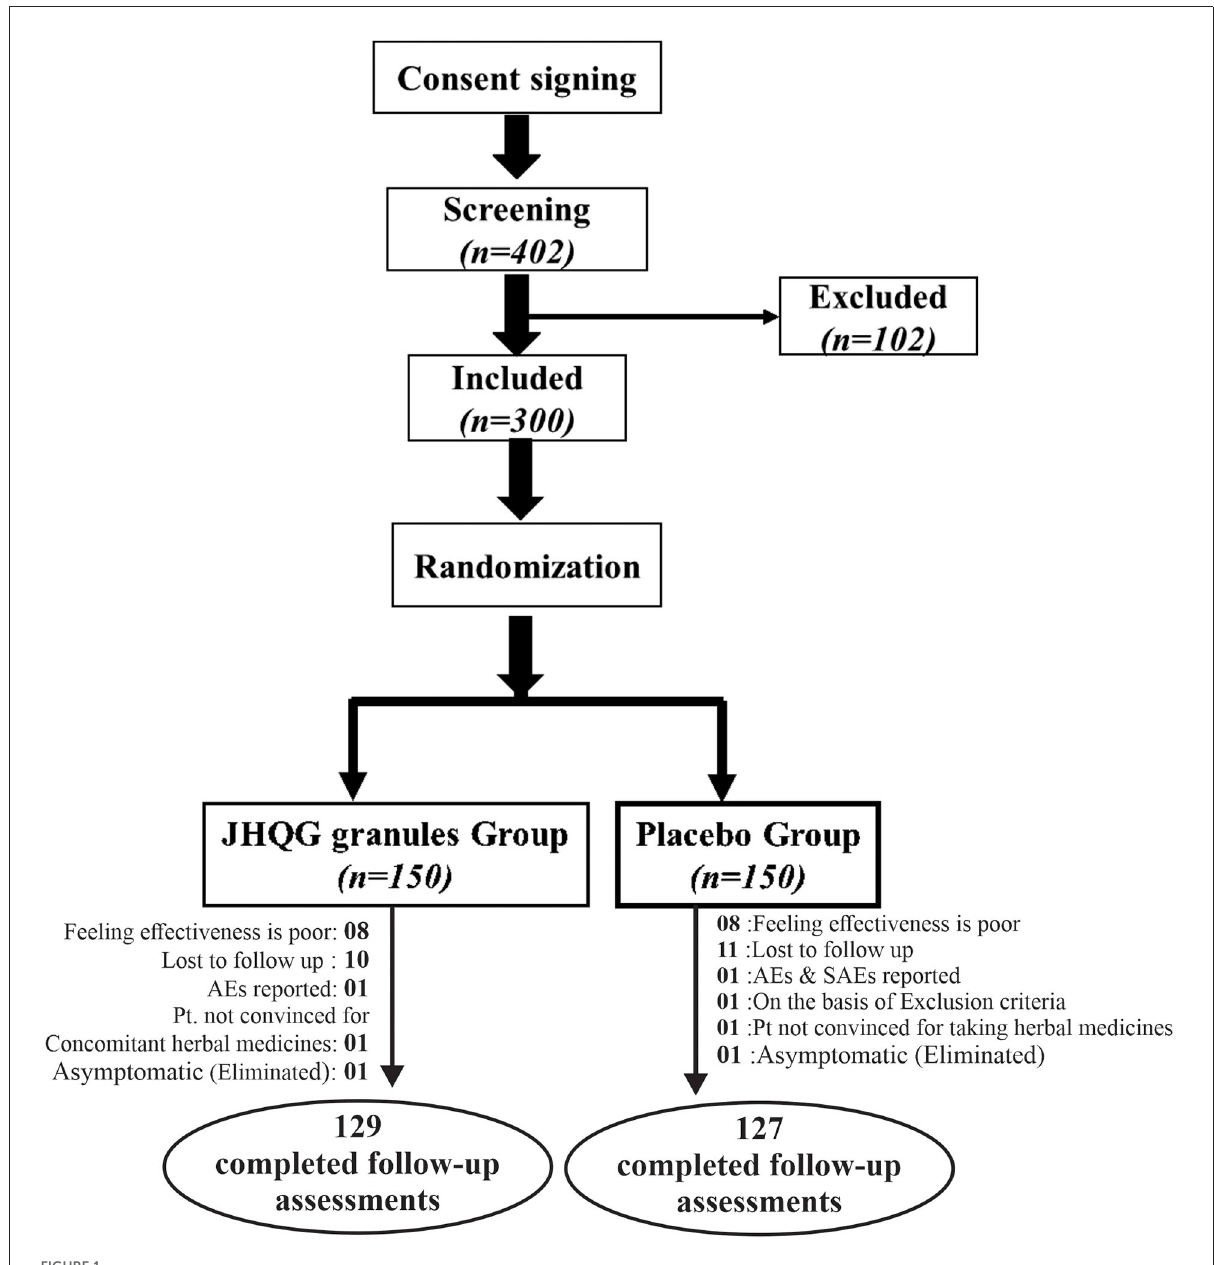
FIGURE1 Flowchart of screening, randomization, and treatment of